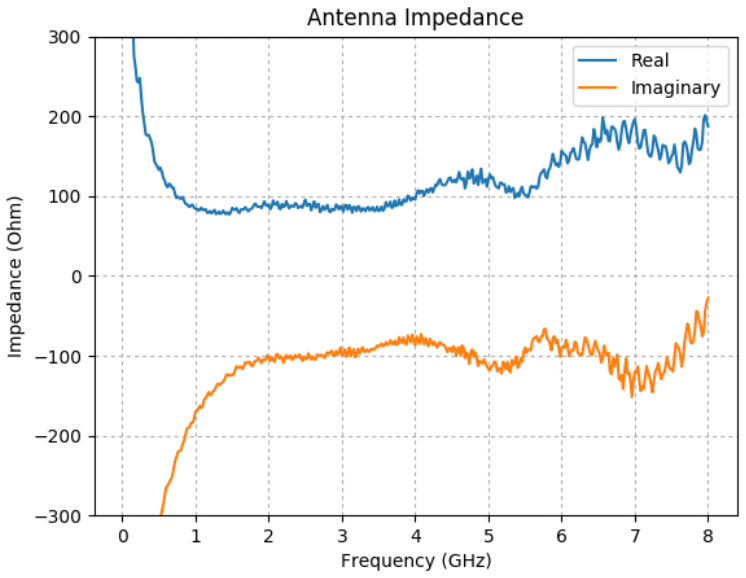
Figure 5. The geometry of one half of the loaded bowtie antennas.